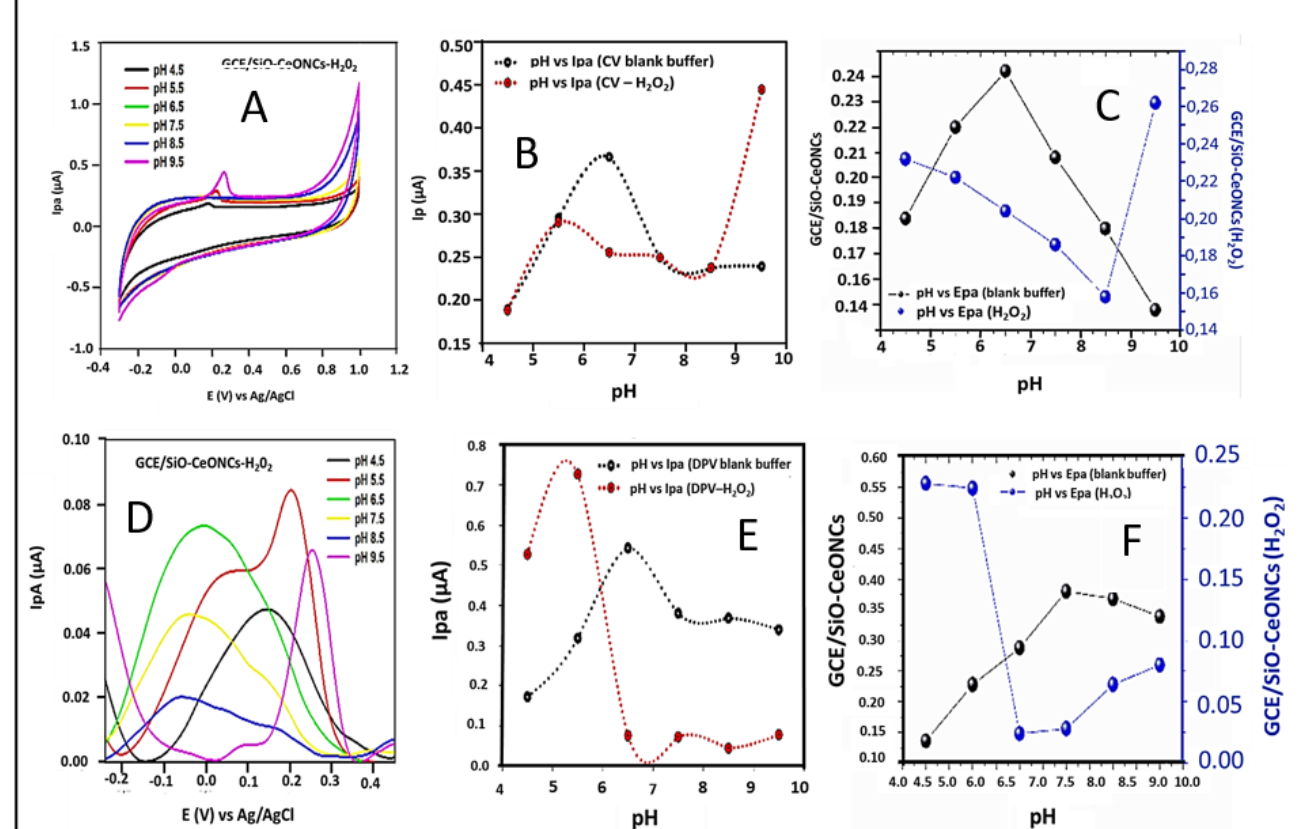
Figure 3. Effect of pH ( A , D ), variation of current vs. pH ( B , E ), and potential vs. pH ( C , F ) in PB solution using CV and DPV at GCE/SiO ‐ CeONCs. H 2 O 2 concentration, 30 nM; scan rate, 30 mV s –1 ; pulse amplitude, 50 mV; pulse width, 30 s.